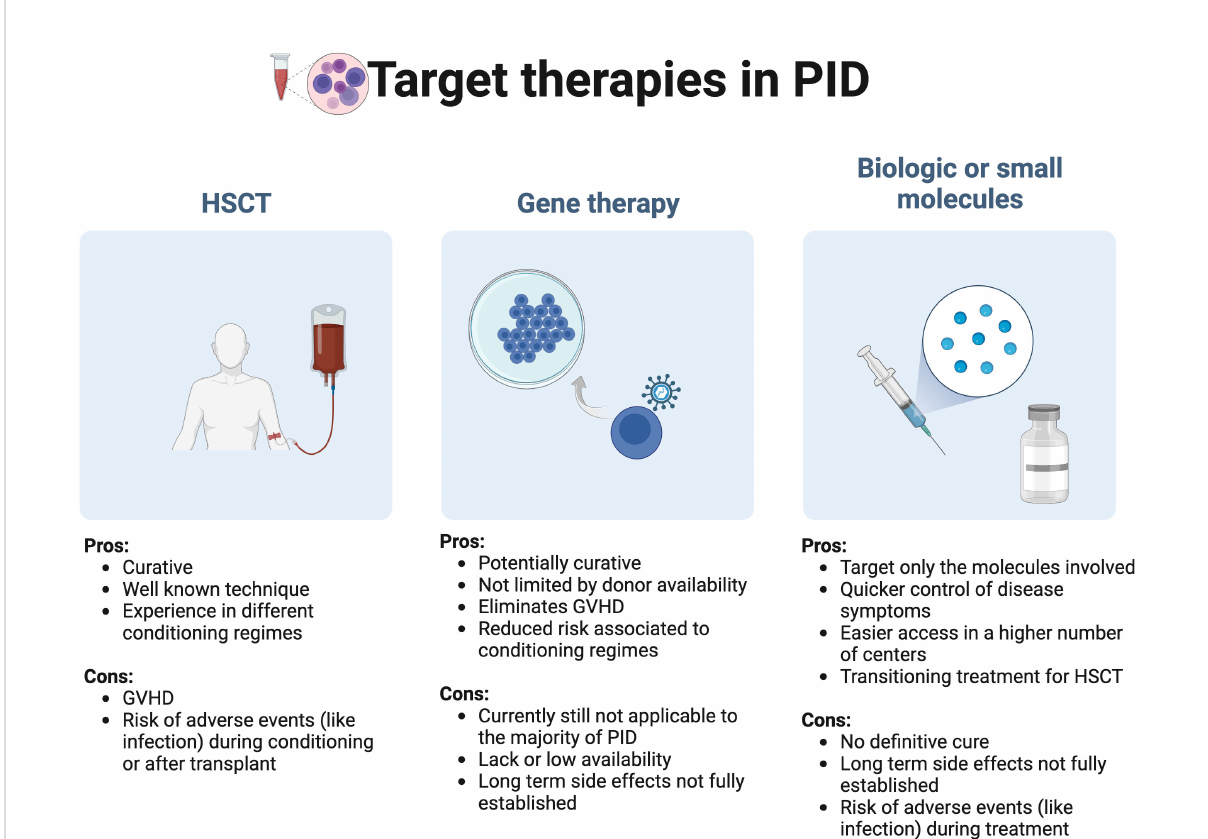
FIGURE 2 Target primary immunode fi ciencies (PID) therapies in precision medicine: A general overview GVHD, Graft versus host disease; HSCT, hematopoietic stem cell